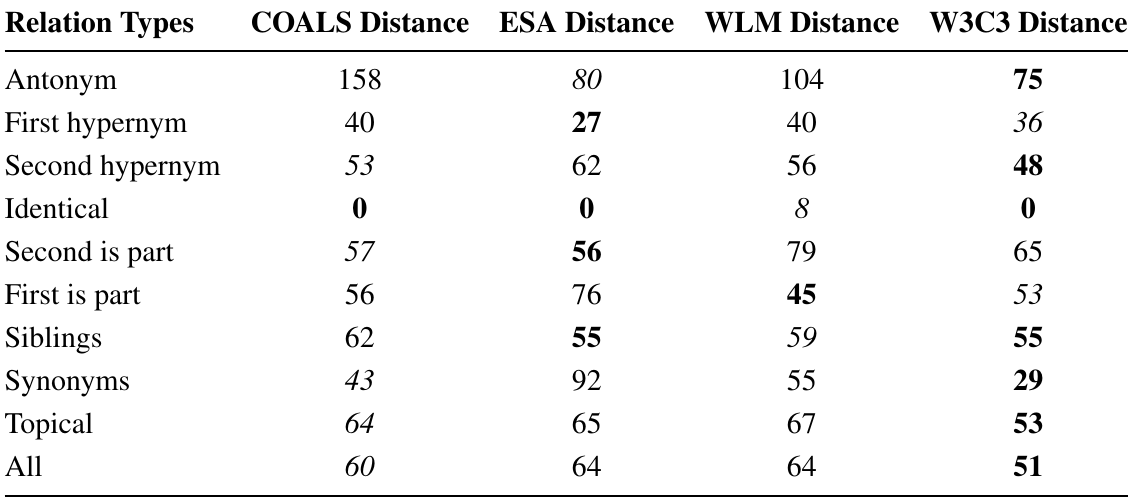
Table 5. Average distance by WordSimilarity-353 semantic category.